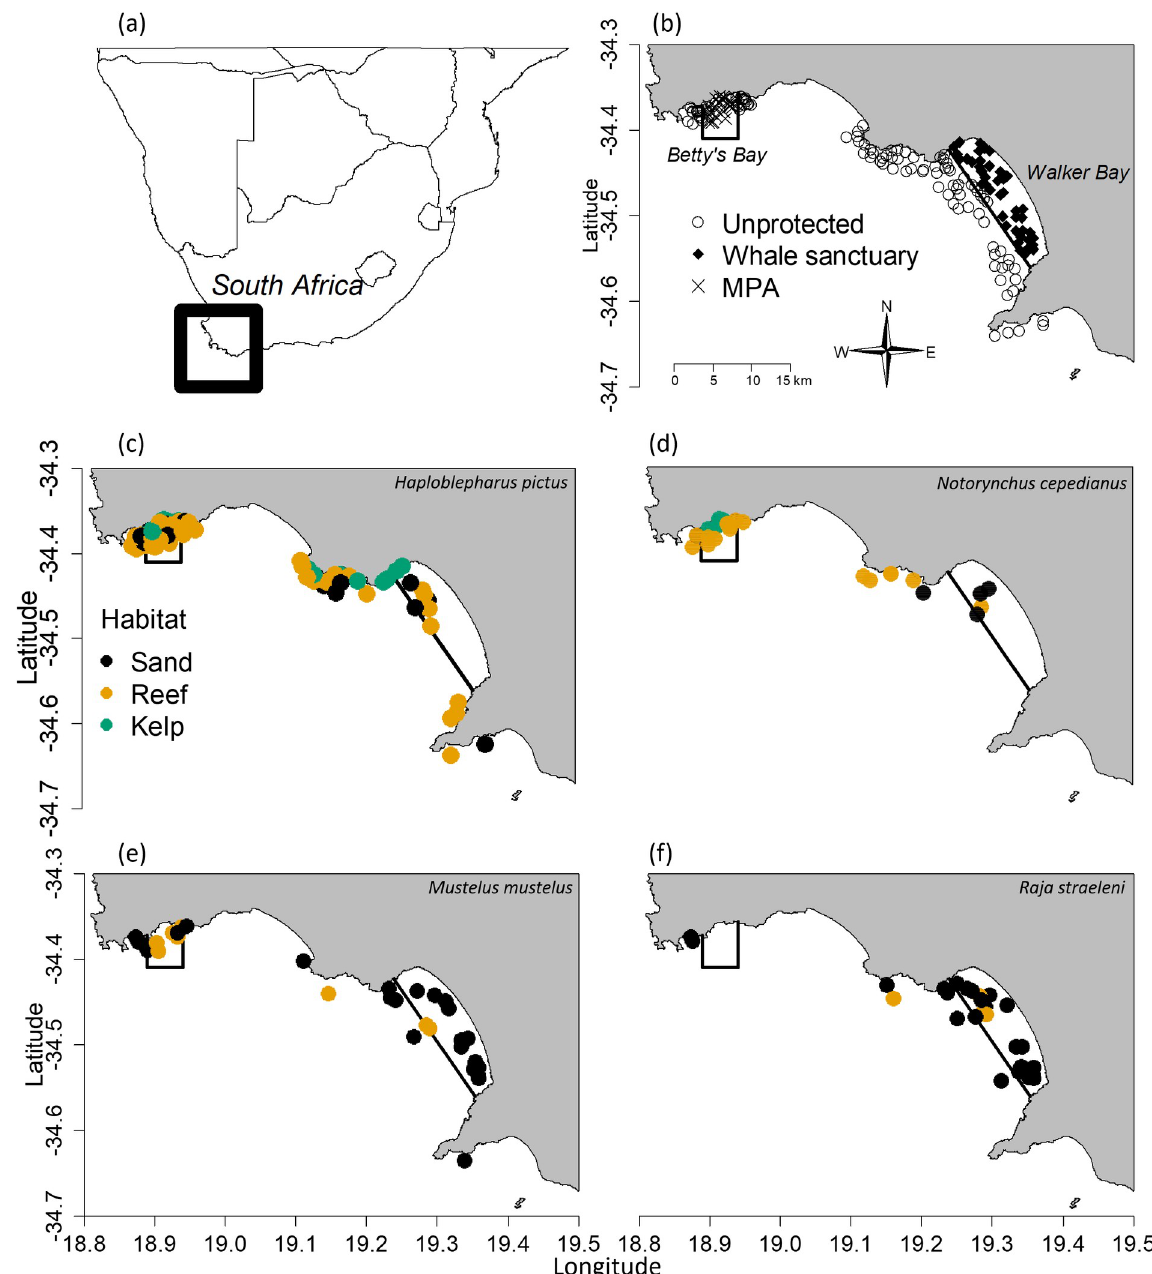
Fig 1. Maps of sampling sites showing protection levels and locations and habitats of commonly observed species. (a) The study area within southern Africa (black circle); (b-f) maps of the study area showing (b) the two protected areas (Walker Bay Whale Sanctuary; Betty’s Bay MPA) with all BRUV sites categorized by protection level; observations of five representative species categorized by habitat type: (c) dark shyshark Haploblepharus pictus (most abundant shark); (d) broadnose sevengill shark Notorynchus cepedianus (most abundant high trophic level shark); (e) common smooth-hound shark Mustelus mustelus (most abundant triakid); and (f) biscuit skates Raja straeleni (most abundant endemic batoid). Legend for habitat colour in (c) applies to